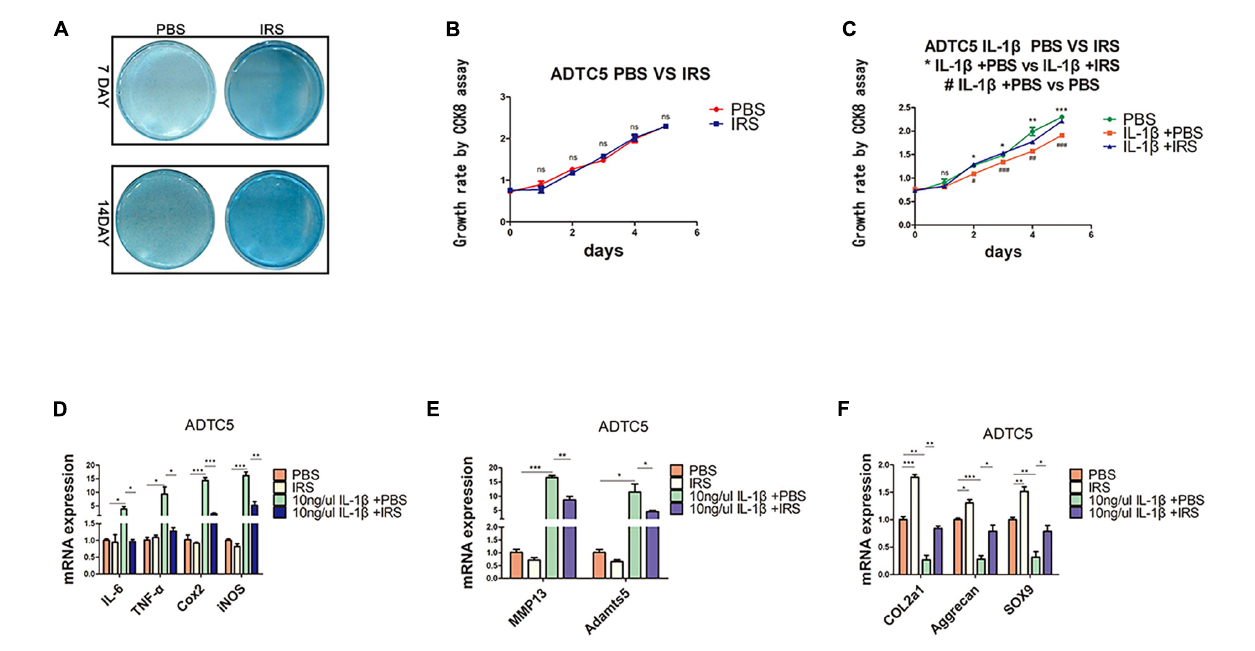
FIGURE 3 | Chondrogenic differentiation, proliferation and inflammation changes in ADTC5 cells. (A) Alcian Blue staining of ADTC5. (B,C) CCK8 assay reveals the change of cell proliferation in vitro ( ns p > 0.05, ∗ / ∗∗ / ∗∗∗ means the comparison between group IL-1Îš + PBS and group IL-1Îš + irisin, # / ## / ### means the comparison between group IL-1Îš + PBS and group PBS, *, # p < 0.05, **, ## p < 0.01, ***, ### p < 0.001). (D–F) Gene expression of inflammatory cytokines, inflammatory mediators, catabolic enzymes and anabolic genes expression in ADTC5 cells ( ns p > 0.05, * p < 0.05, ** p < 0.01, *** p < 0.001).